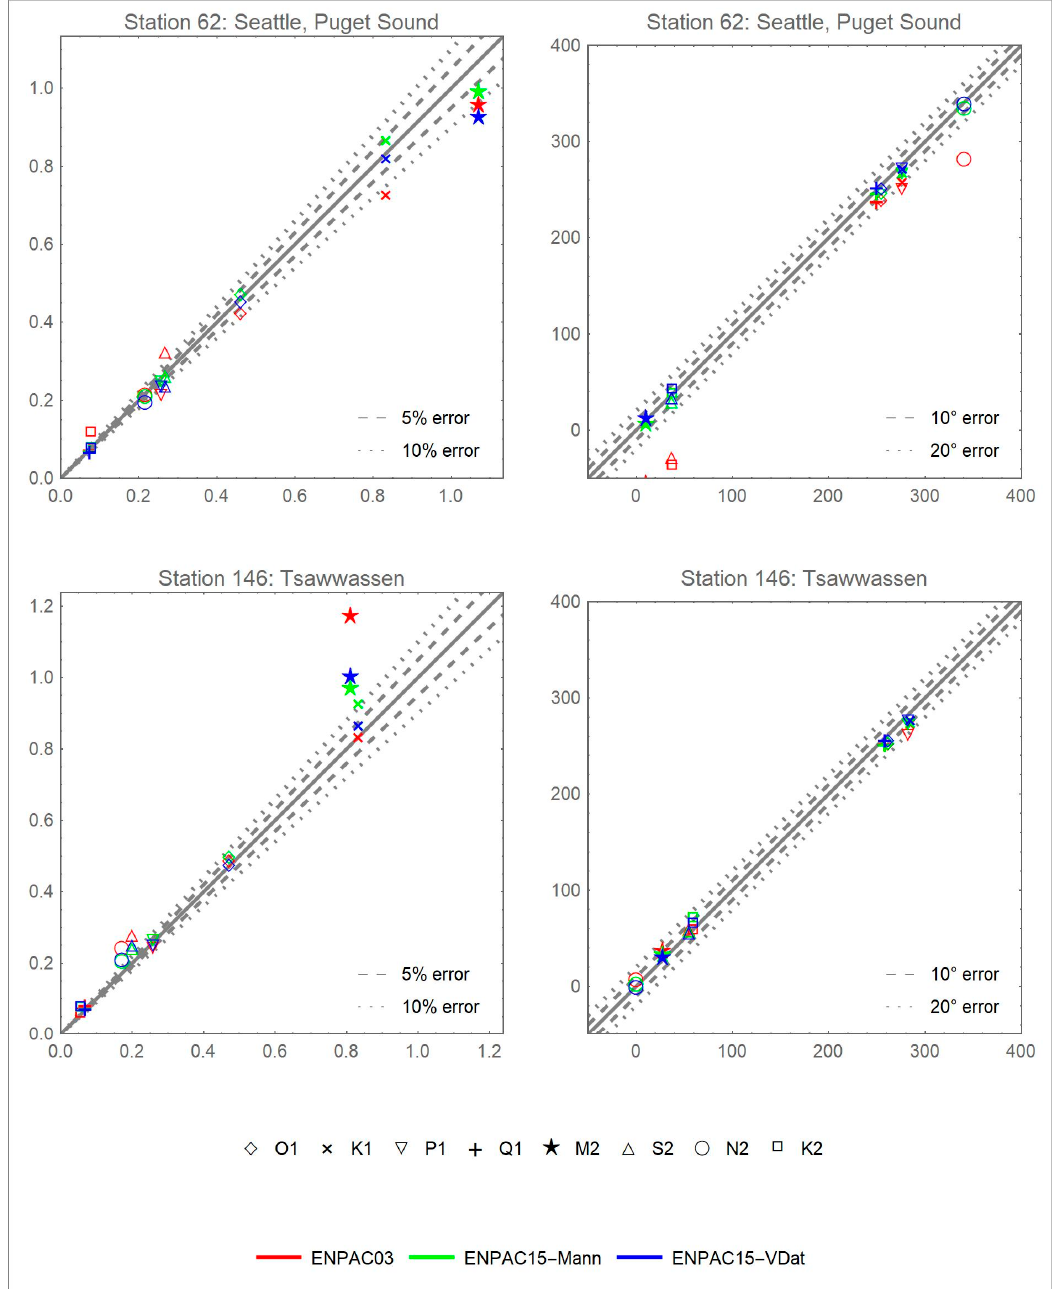
Figure A10. Scatterplots of errors for two Puget Sound stations, locations shown in Figure A3.